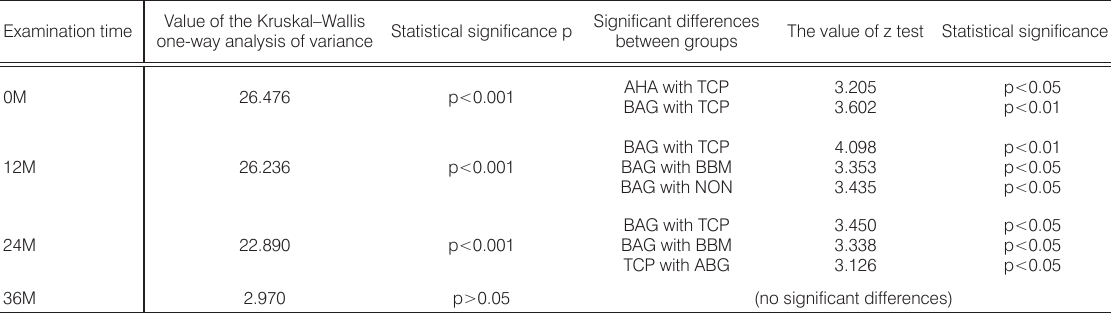
Table 2. Comparison of results between the groups in the different time